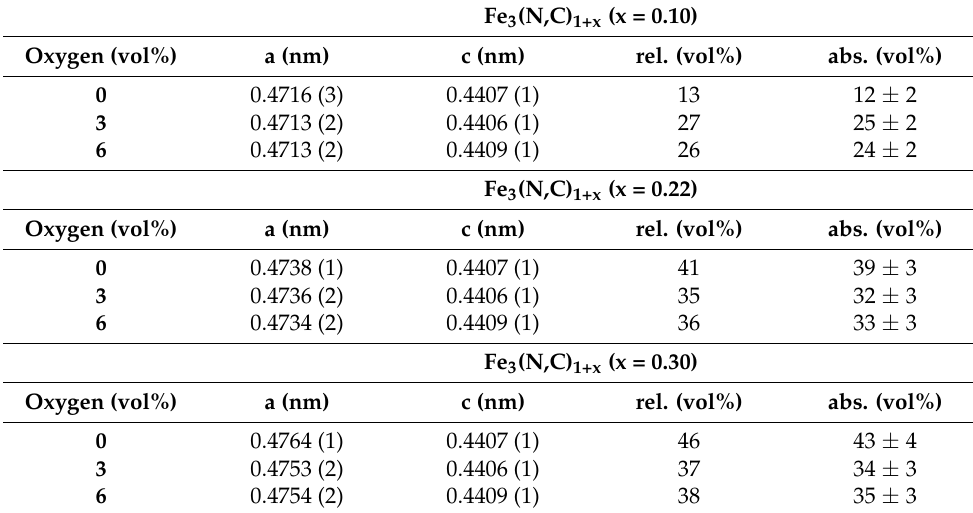
Table 2. Structure, lattice parameters, and the quantitative fraction (relative and absolute) of ε - Fe 3 (N,C) 1+x (x = 0.10, 0.22, 0.30; values for x estimated from [27]) determined by X-ray diffraction and Rietveld